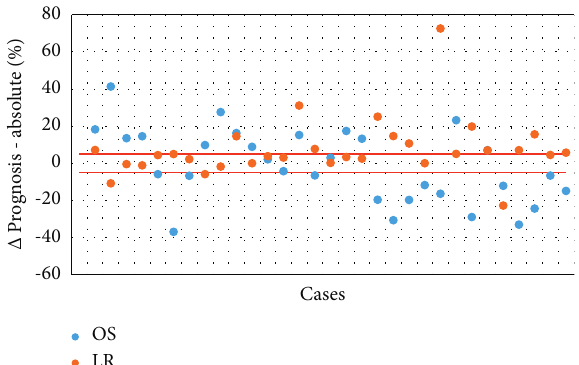
Figure 1: Differences in the prognosis of OS/LR.